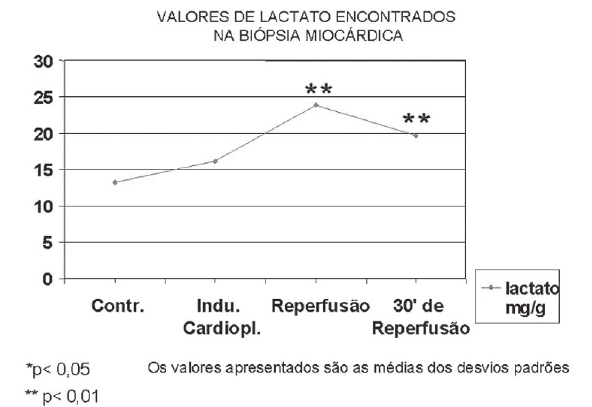
Fig. 3 – Valores de lactato encontrados na biópsia miocárdica